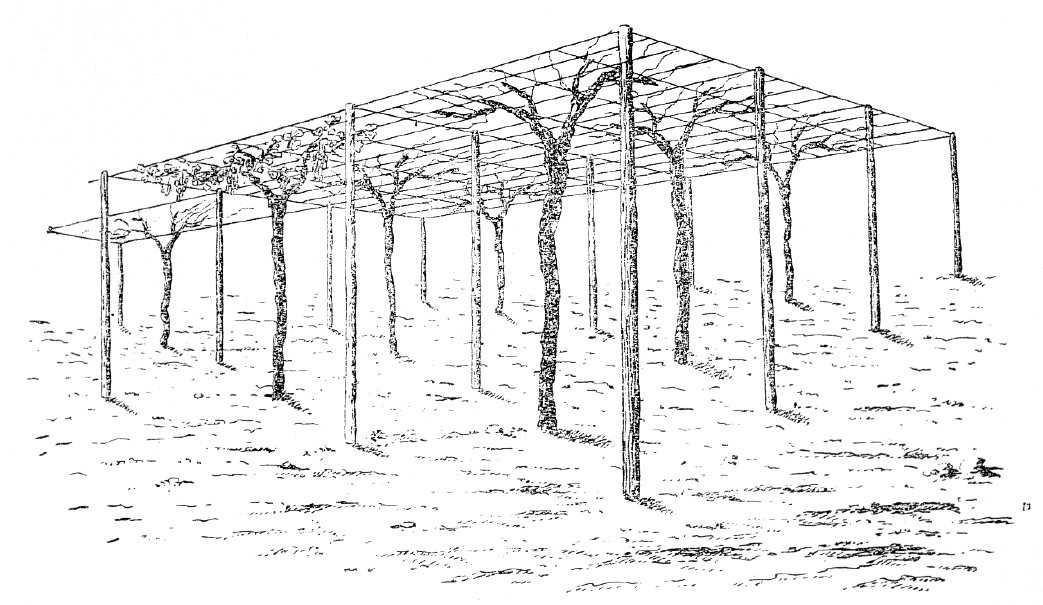
Figure 1. The Spanish parral training system showing vines, structure and wires used to support canopy and crop load.